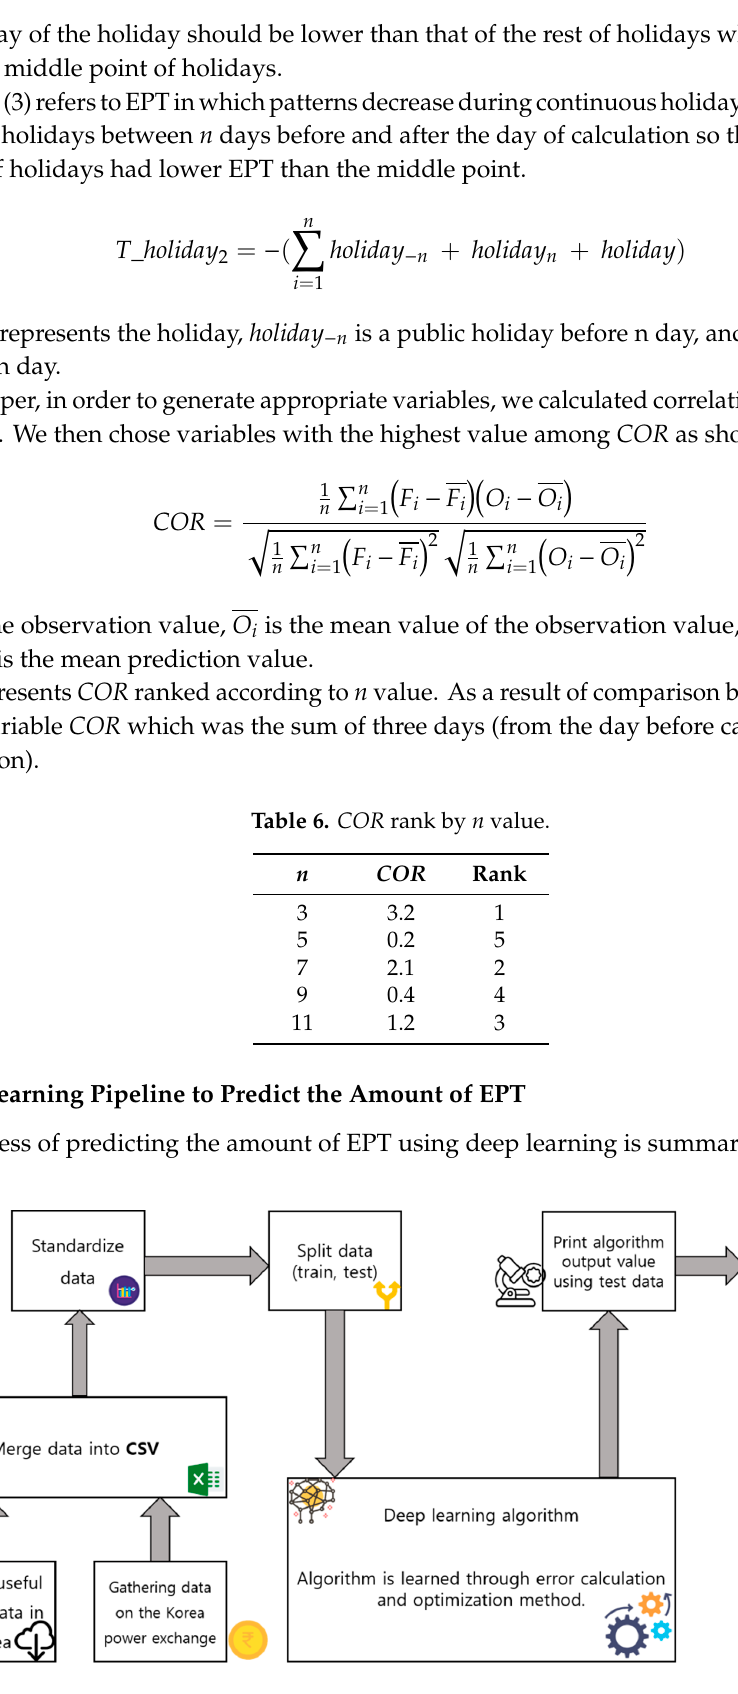
Figure 14. Algorithm used for predicting the amount of EPT.